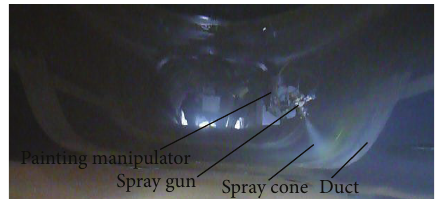
Figure 21: Painting experiment in irregular duct.